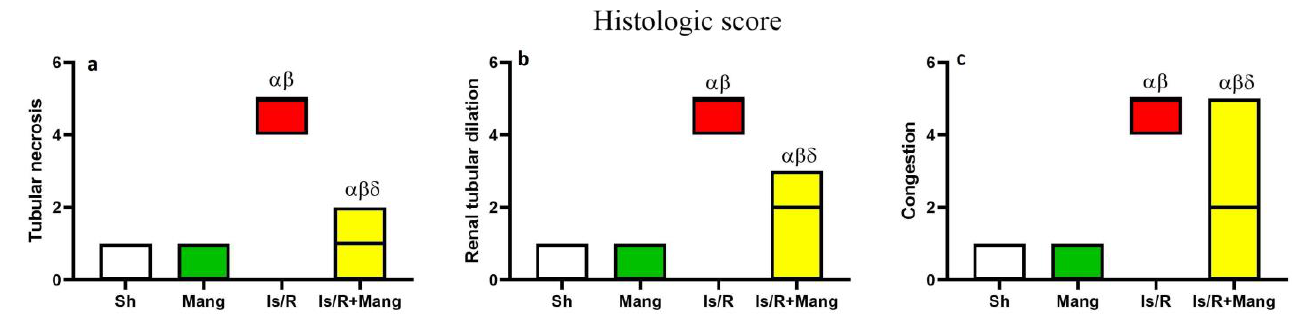
Figure 9. Mang ’s (20 mg/kg, i.p) impact on renal ( a ) tubular necrosis, ( b ) tubular dilation, and ( c ) congestion as histologic scores after bilateral renal Is/R (45 min/24 h) in Wistar rats. As compared with sham ( α ), Mang ( β ), and Is/R ( δ ) treated groups.